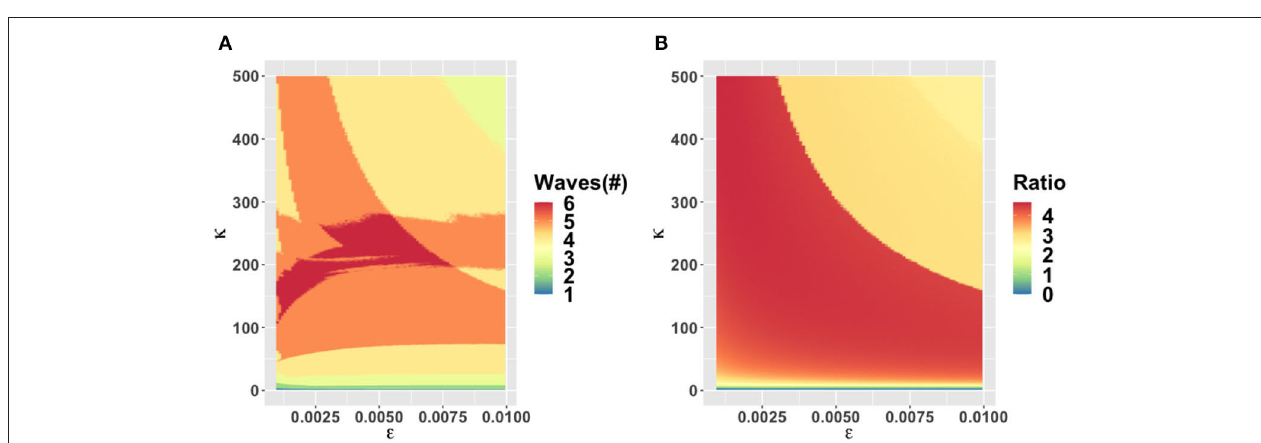
FIGURE 4 | Parameter plane showing model dynamics as they vary with changes in the rate κ that controls the social learning rate and the parameter ǫ which controls how sensitive the population is to economic losses relative to infection prevalence, for the number of COVID-19 waves (A) and the ratio of peak height of the second wave to the first wave peak (B) . Other parameters are at baseline values ( Table 1